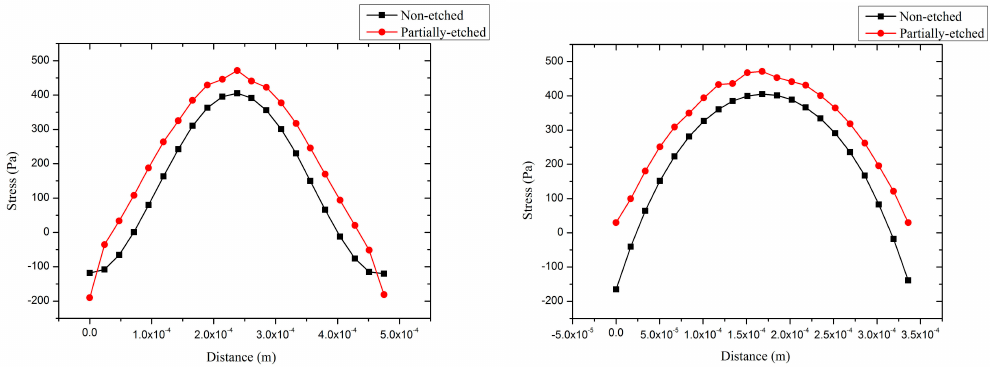
Figure 7. The stresses distributions in piezoelectric film of pMUT with whole and partially-etched ZnO films along P1 ( left ) and P2 ( right ) lines.